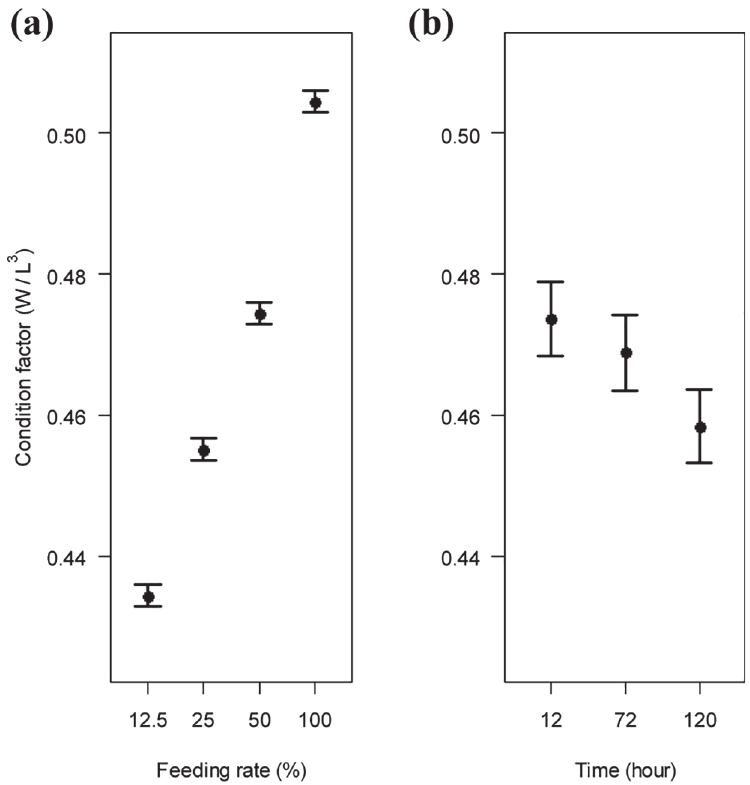
Fig 4. Generalized additive model fits and 95% confidence intervals from the optimal model for white sturgeon. Relationships between growth performance, measured by condition factor, and each explanatory variable are illustrated. Sturgeons were challenged in a multiple-factor setting, first to levels of feeding rate (12.5, 25, 50, 100%), and then to salinity levels (0, 8, 16, 24 ppt) for a given time (12, 72, 120 h). Only feeding rate and time were kept in the final model. W = weight; L =